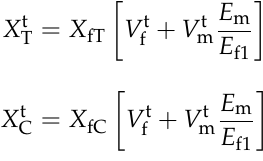
of each lamina with V l f